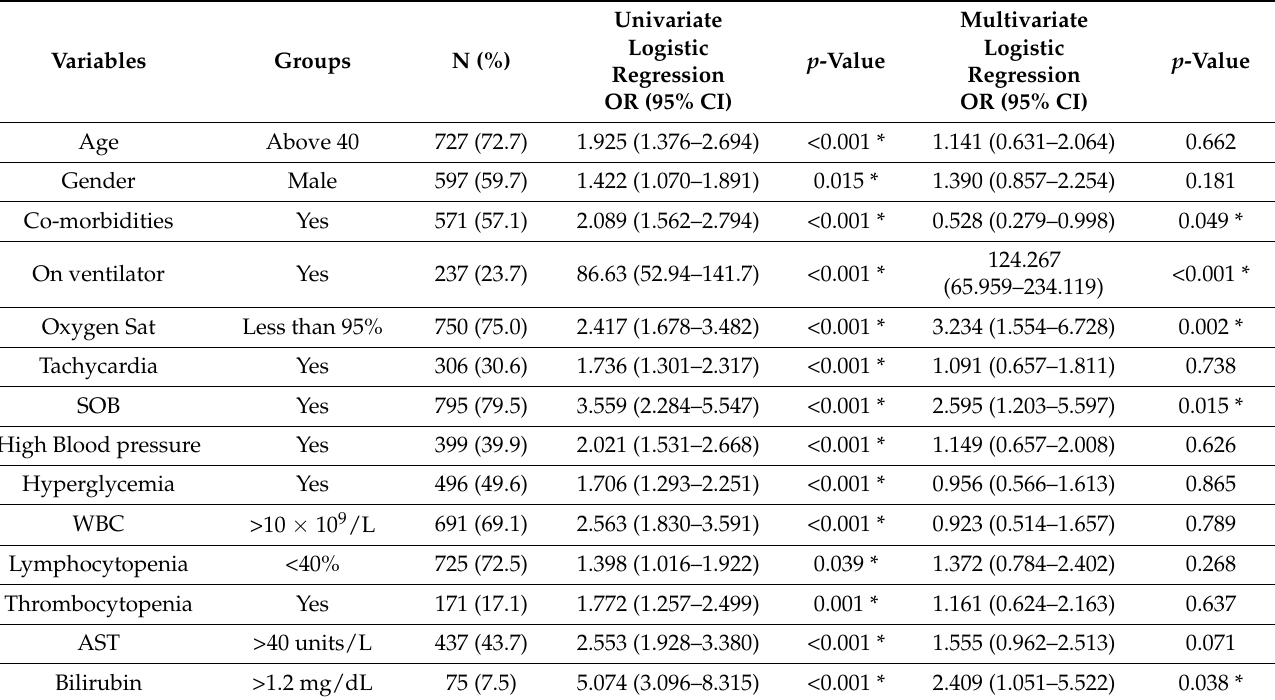
Table 4. Univariable and multivariable analysis on the predictors of